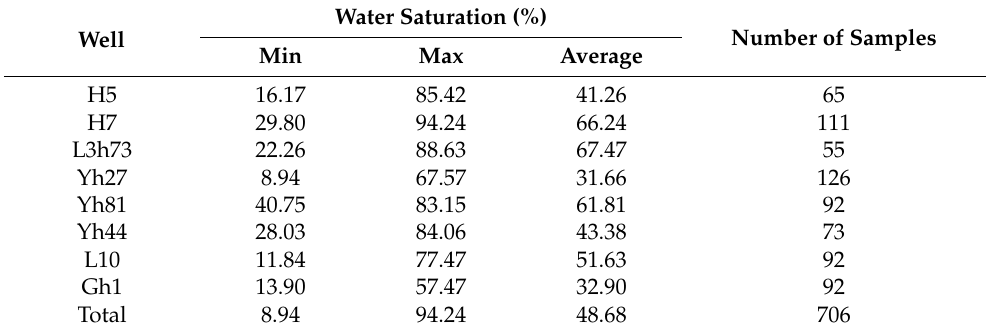
Table 6. Water saturation of the Longmaxi Formation shale of different drilling wells in the study area.